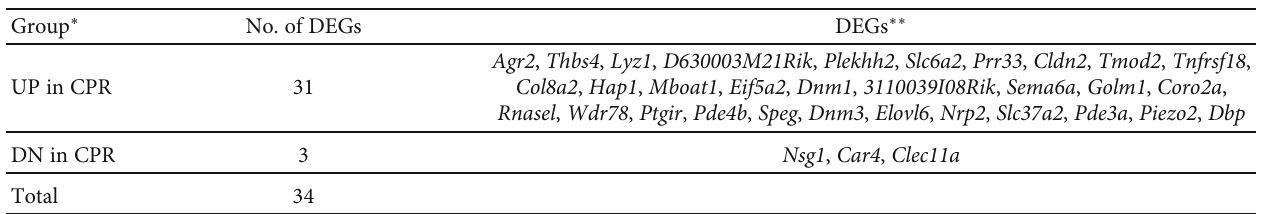
Table 2: DEGs speci fi c to